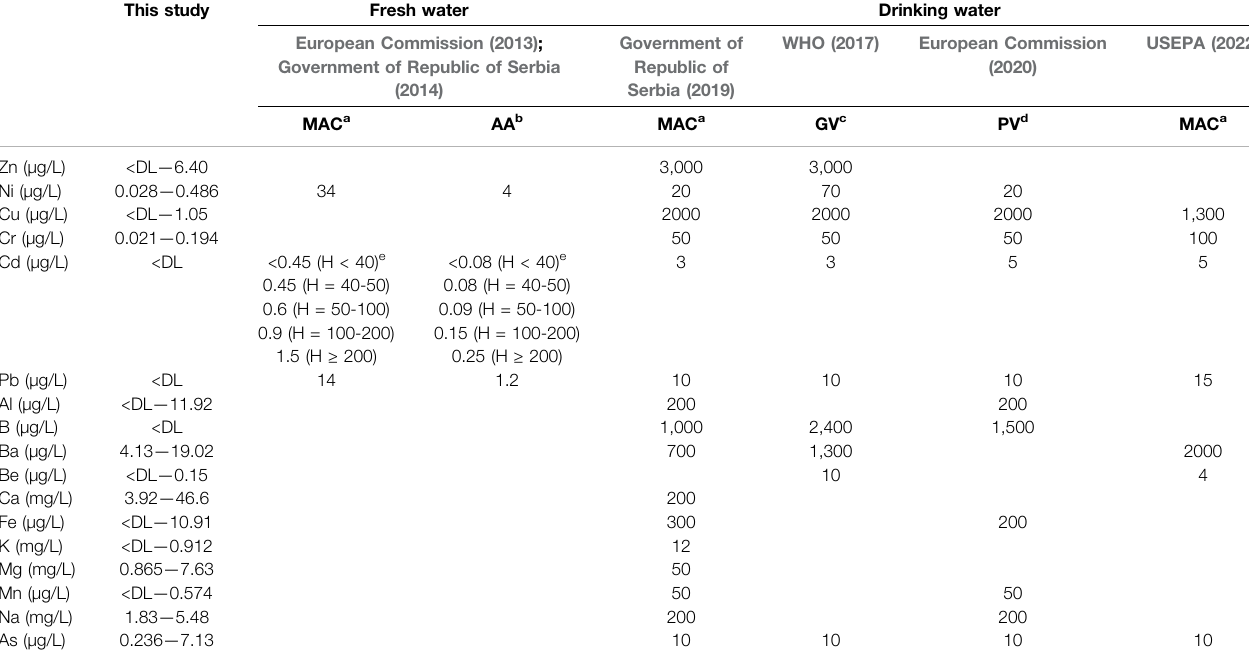
TABLE 4 | Comparison of water quality in the present study with water quality